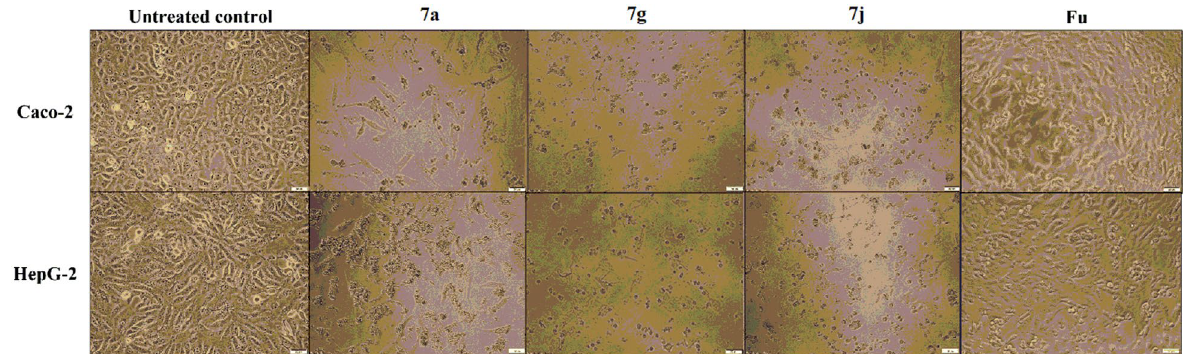
Figure 8 . Morphological alterations of the hit compounds 7a , 7g and 7j -treated cancer cell lines after 72 h, untreated cancer cells and 5-fluororuracil-treated cells.